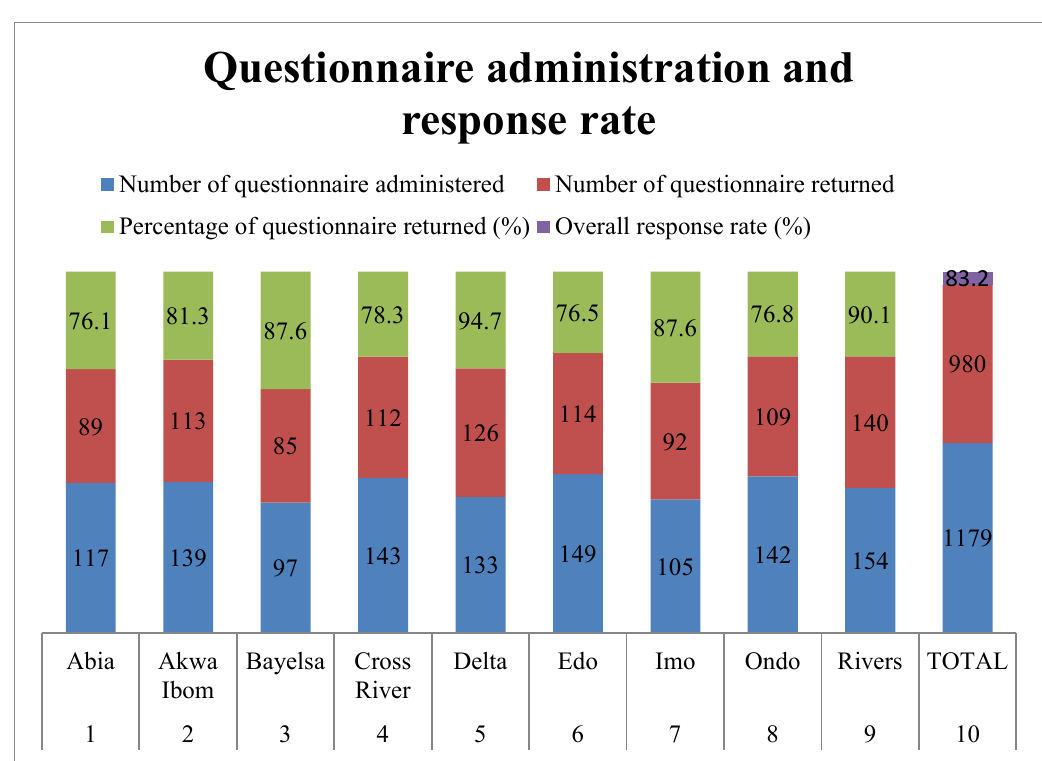
Fig. 2. Questionnaire distribution and response rate (developed by the authors). It also indicates that firms operating in River State had the highest response rate (90.10 %), while the construction firms operating in Abia State had the lowest response rate (76.10